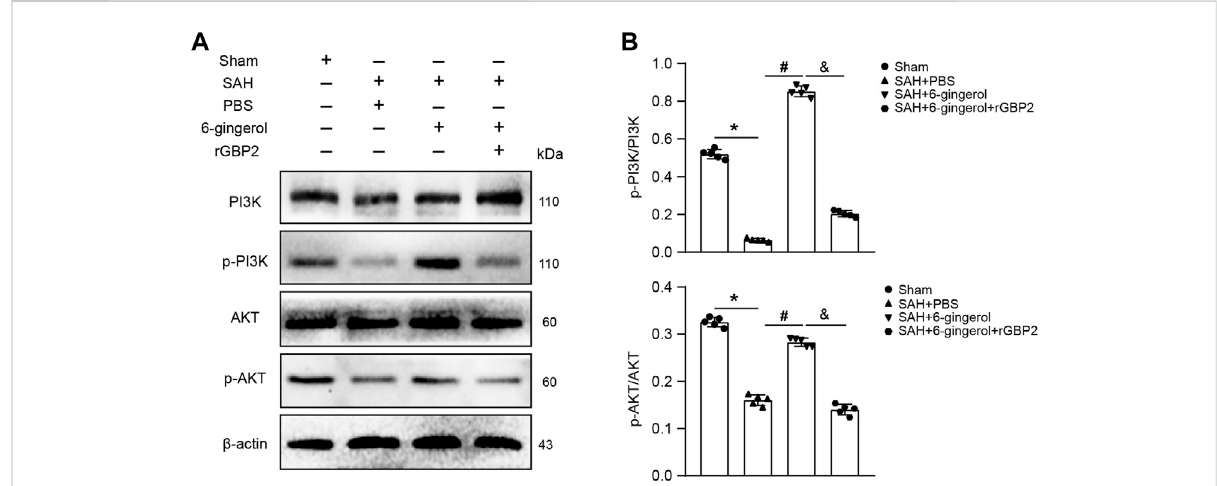
FIGURE 6 6-gingerol activates the PI3K/AKT pathway to inhibit GBP2-mediated neuronal apoptosis in SAH rats. (A) Western blotting analysis of PI3K, p-PI3K,AKT,p-AKT,bax,bcl-2andcaspase8proteinexpression. (B) Quantitativewesternblot,n=5.One-wayANOVAwasusedfollowedbyTukey ’ s post hoc test. * p < 0.05 vs sham group; # p < 0.05 vs SAH + PBS group; & p < 0.05 vs SAH + 6-gingerol